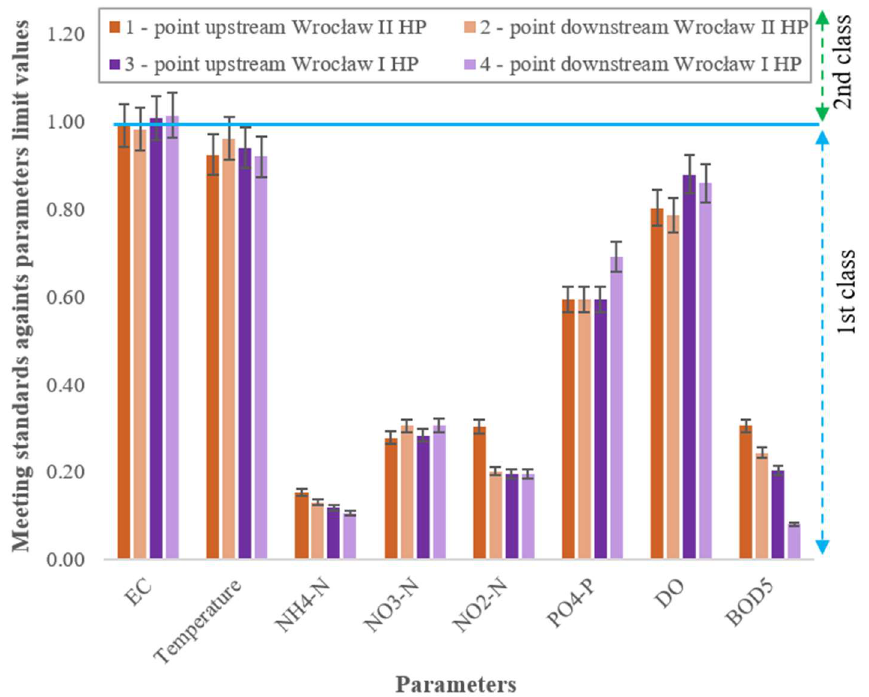
Figure 3. Indicators of exceedances of the physicochemical status for the tested parameters within the Wrocław I and Wrocław II hydropower plants.